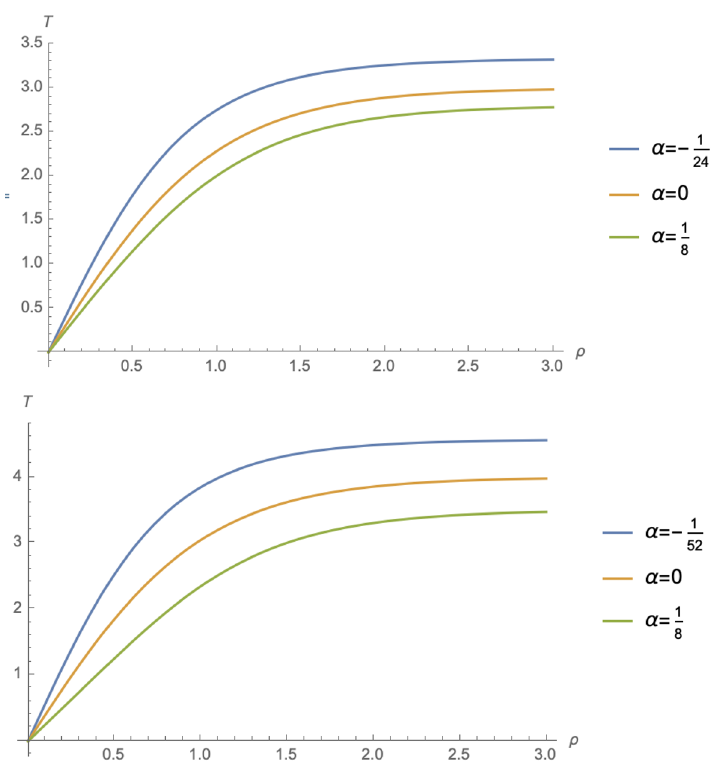
Figure 3 . Brane tension T for d = 4 (above) and d = 5 (below). The blue line, orange line and green line correspond to the lower bound, zero and the upper bound of the Gauss-Bonnet coupling α . The brane tension T is positive for ρ > 0 and increases with ρ . The smaller α is, the larger the tension